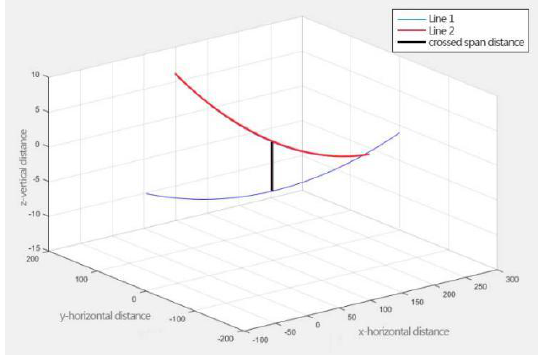
Figure 5. Simulation under windless condition